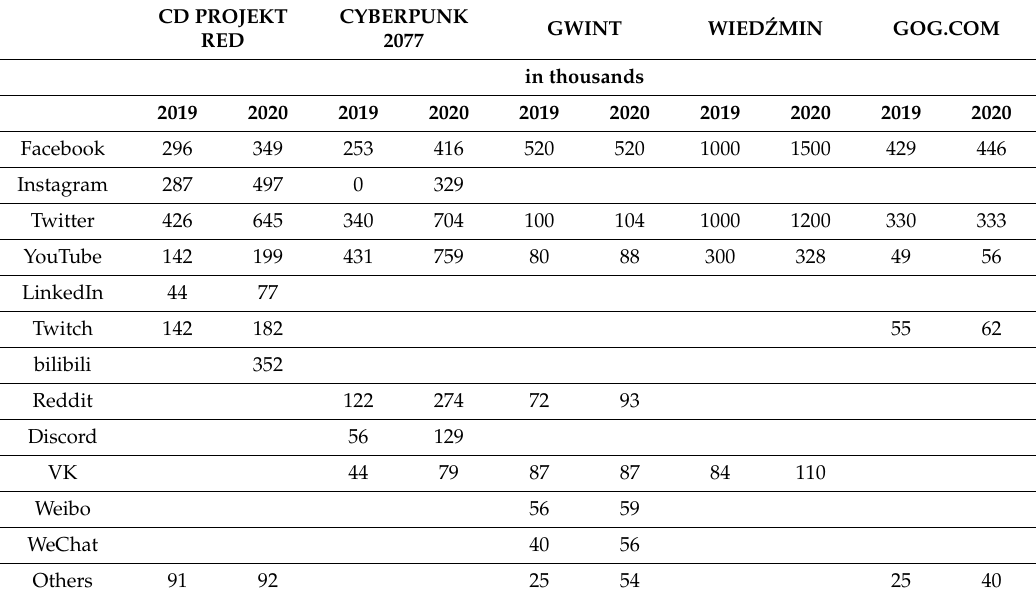
Table 2. The number of followers and